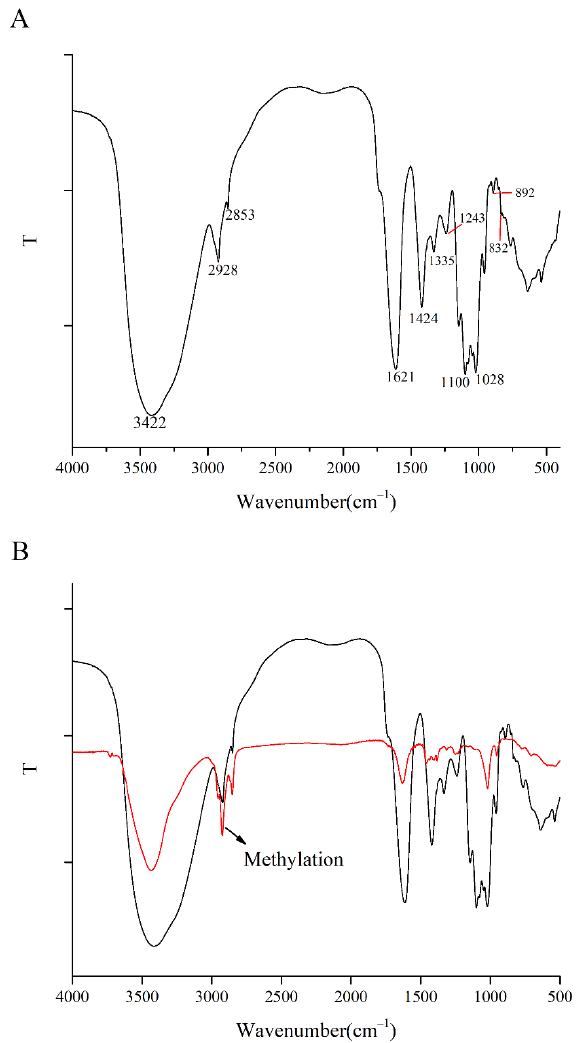
Figure 3. ( A ) IR spectrum of HCPS, ( B ) IR spectrum of methylated HCPS.